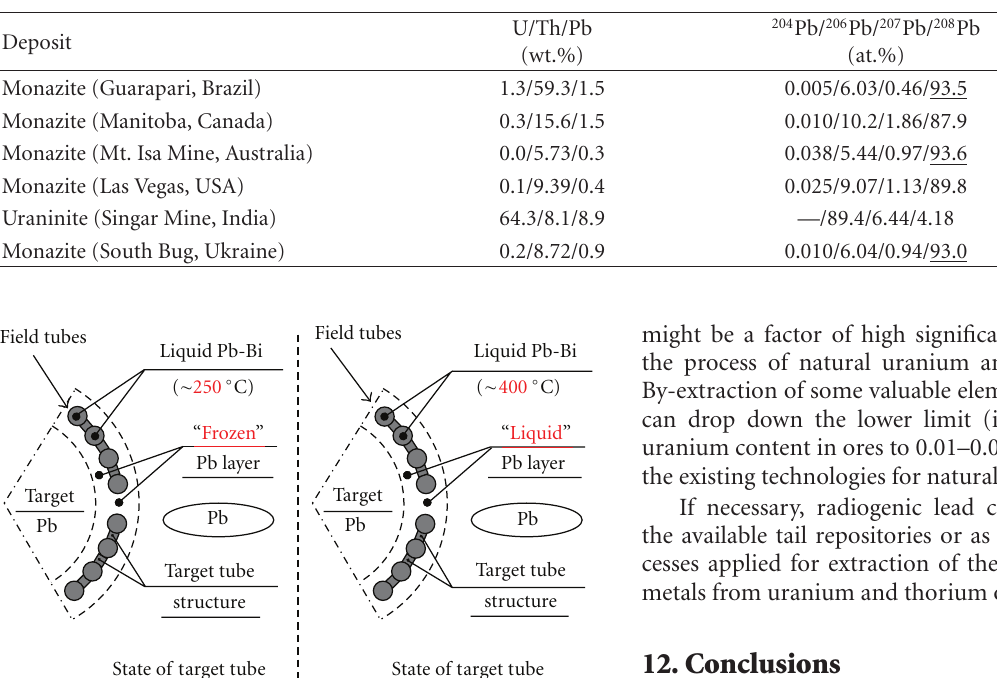
Figure 11: The principal scheme of high-flux ADS with zone for RAW transmutation. Table 8: Main deposits of uranium, thorium, and mixed uranium-thorium ores. Elemental compositions of minerals and isotope compositions of radiogenic lead.